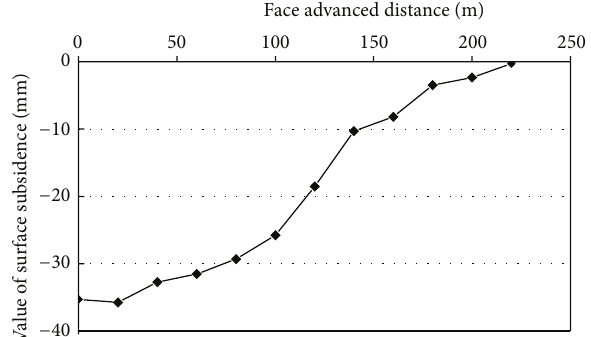
Figure 4: A practical measuring curve of the surface subsidence induced by paste backfill